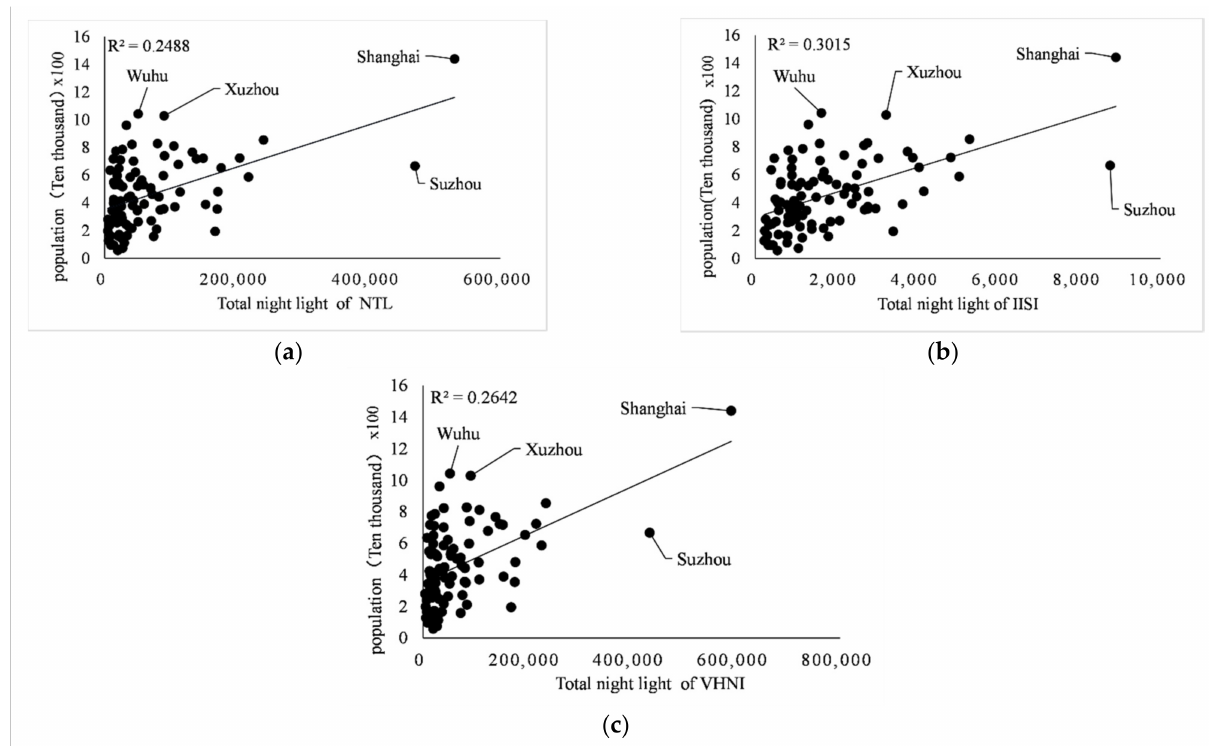
Figure 7. ( a – c ) Linear fitting relationships between NTL , IISI , VHNI and population respectively.